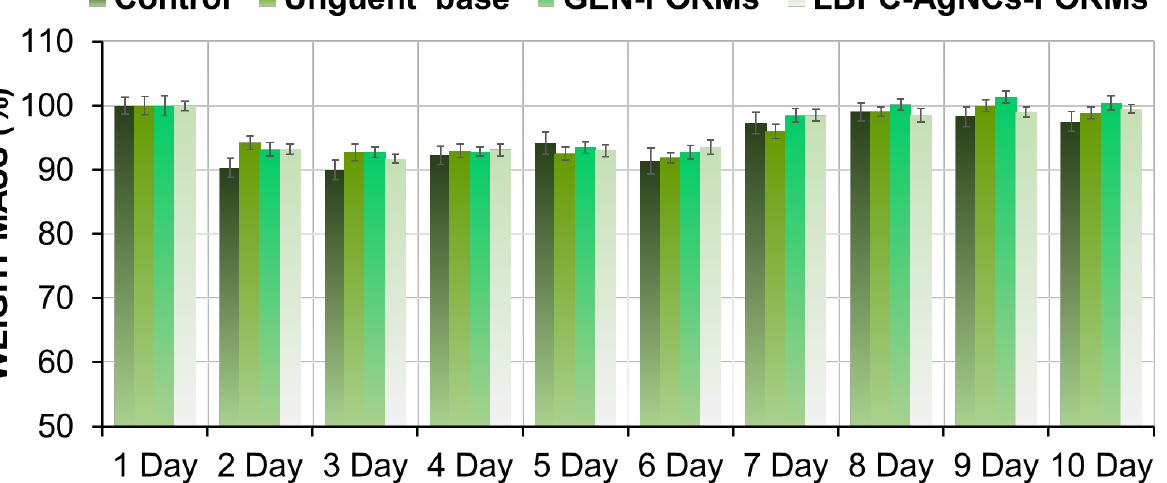
Figure 1. The animal weight mass represented in % during the 10 days of examination.